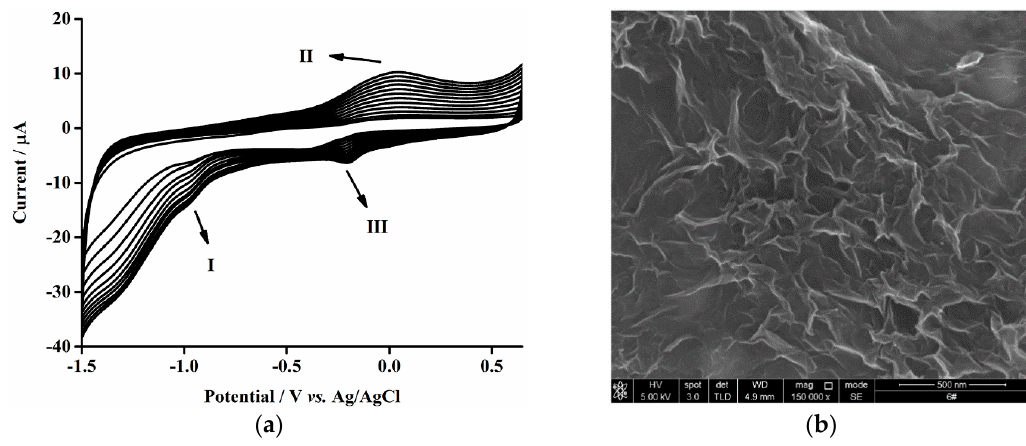
Figure 2. ( a ) CV of bare GCE in 0.07 M Na 2 HPO 4 aqueous solution (pH 9.2) containing 2.0 mg·mL − 1 GO. The scan cycle: 12 cycles; potential range: − 1.5 to 0.65 V; scan rate: 50 mV·s − 1 . ( b ) The SEM image of